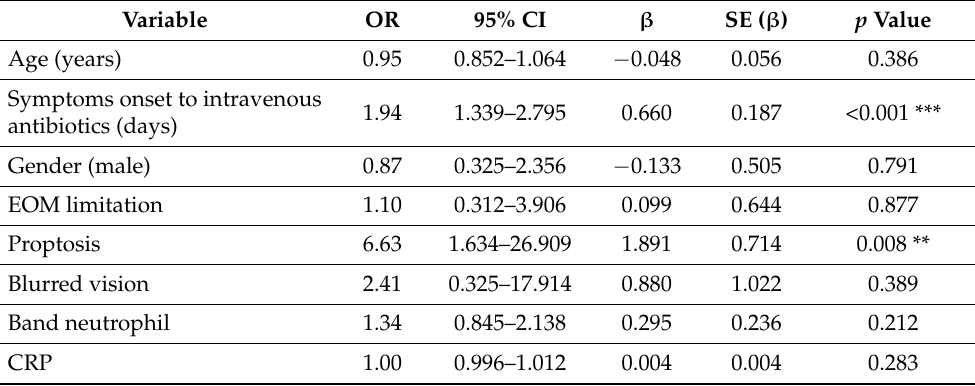
Table 4. Multivariate logistic regression analysis of the clinical characteristics related to surgical inter-